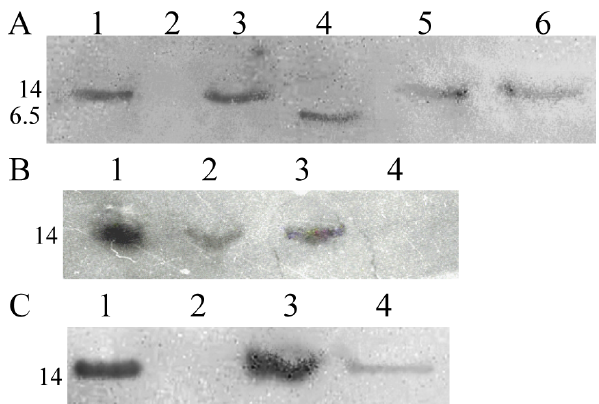
Figure 6. HrpB2 XAC is secreted by Xac . Liquid cultures of Xac were grown as described in Materials and Methods. Secreted fractions were concentrated and separated by SDS-PAGE 18% and proteins were tran- sferred to nitrocellulose membranes. HrpB2 XAC was detected using anti- HrpB2 XAC antiserum and revealed using anti-mouse IgG conjugated with horseradish peroxidase. ( A ) Lane 1: Xac wild-type, lane 2: Xac D hrpB2, lane 3: Xac D hrpB2 + pUFR047_ hrpB2 , lane 4: Xac D hrpB2 + pUFR047 _hrpB2 1-56 , lane 5: Xac D hrpB2 + pUFR047 _hrpB2 1-123 , lane 6: Xac D hrpB2 + pUFR047 _ hrpB2 LQGPR . ( B ) Lane 1: Xac wild-type, lane 2: Xac D hrpB2 + pUFR047 _ hrpB2 T125A , lane 3: Xac D hrpB2 + pUFR047 _hrpB2 Q130A , lane 4: Xac D hrpB2 . ( C ) Lane 1: Xac wild-type, lane 2: Xac D hrcU , lane 3: Xac D hrcU + pUFR047_ hrcU and lane 4: Xac D hrcU + pUFR047_ hrcU AAAH .